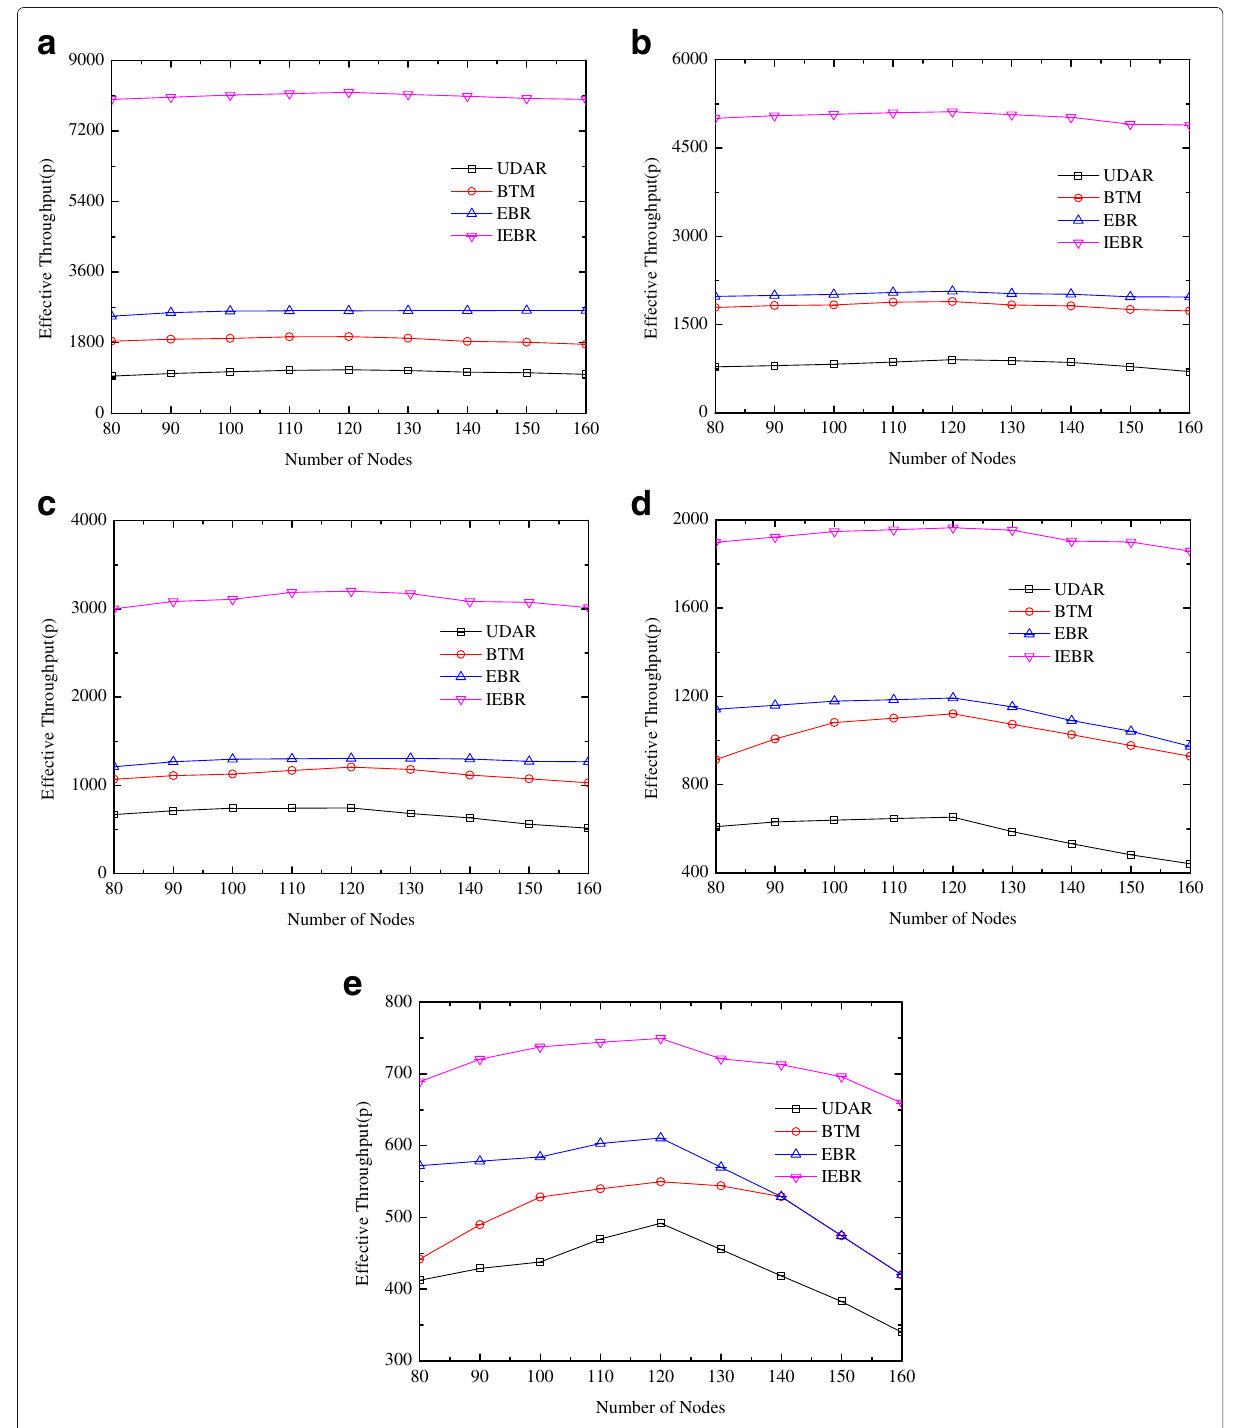
Fig. 12 The effective throughput with different network radiuses and numbers of nodes. a Network radius = 1km. b Network radius = 2km. c Network radius = 3km. d Network radius = 4km. e Network radius =